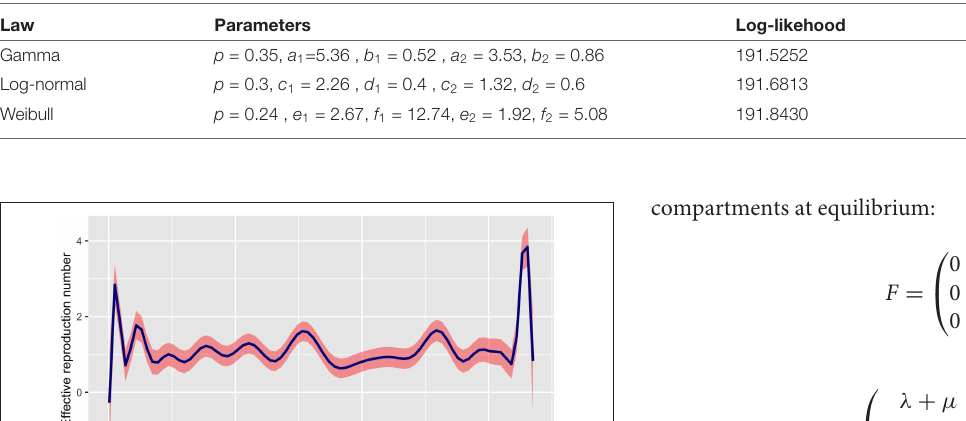
TABLE 3 | Fitted parameter, Log-likehood, AIC, and BIC values with the mixture models.